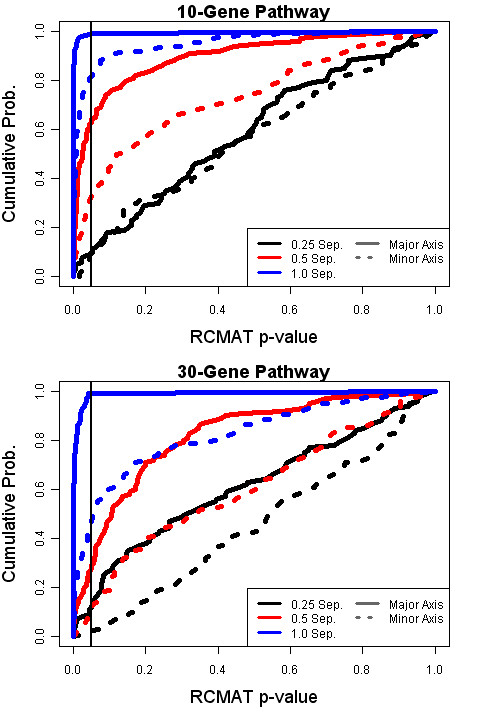
Cumulative distribution function of RCMAT nominal p-values under several simulated non-null conditions. Under each of 12 selected conditions 100 simulation experiments were performed and permutation p-values obtained. The vertical axis is the cumulative distribution function, the proportion of values less than the observed p-value, for the 100 simulated data sets within a condition. A vertical line corresponding to a 0.05 nominal p-value is also provided.